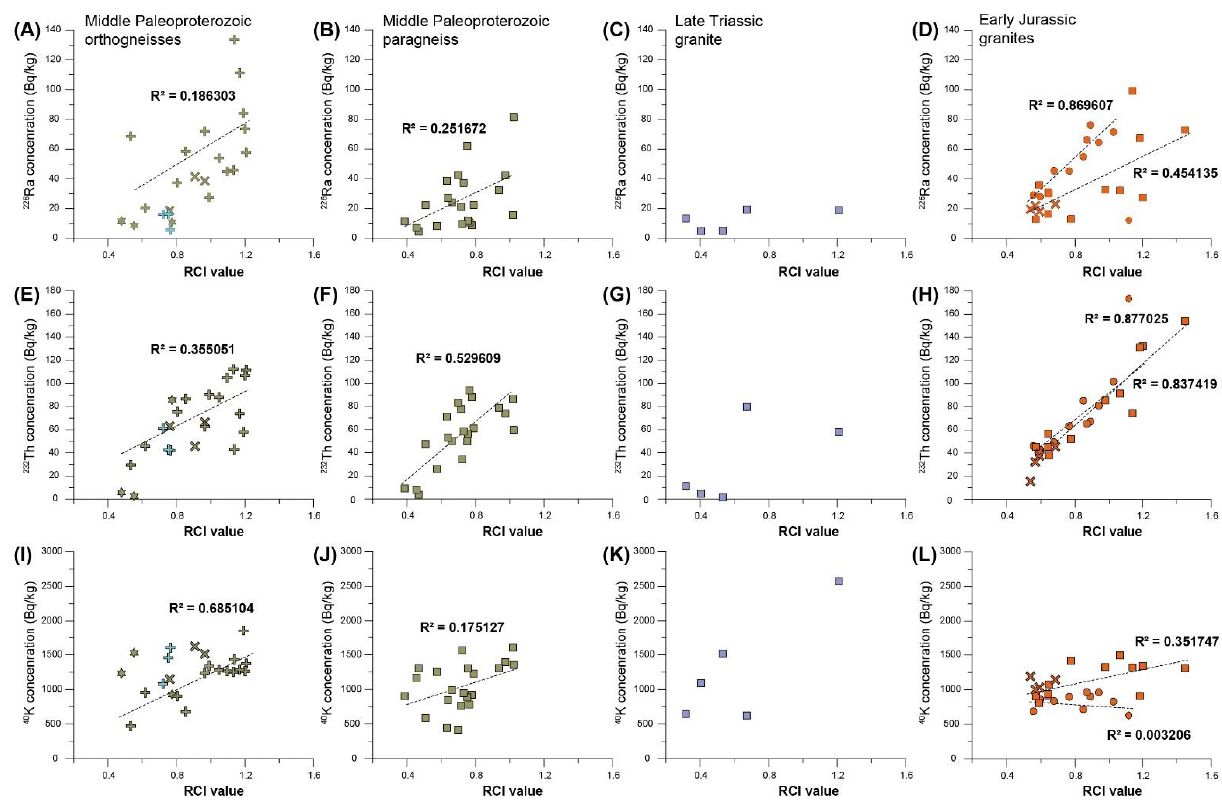
Figure 14. Plots of the concentrations of 226 Ra, 232 Th, 40 K, and RCI values for the Middle Paleoproterozoic orthogneisses ( A , E , I ), Middle Paleoproterozoic paragneisses ( B , F , J ), Late Triassic granite ( C , G , K ), and Early Jurassic granites ( D , H , L ) in the Jangsu-gun area. RCI, radiation concentration index. Symbols are as in Figures 6 and 7.